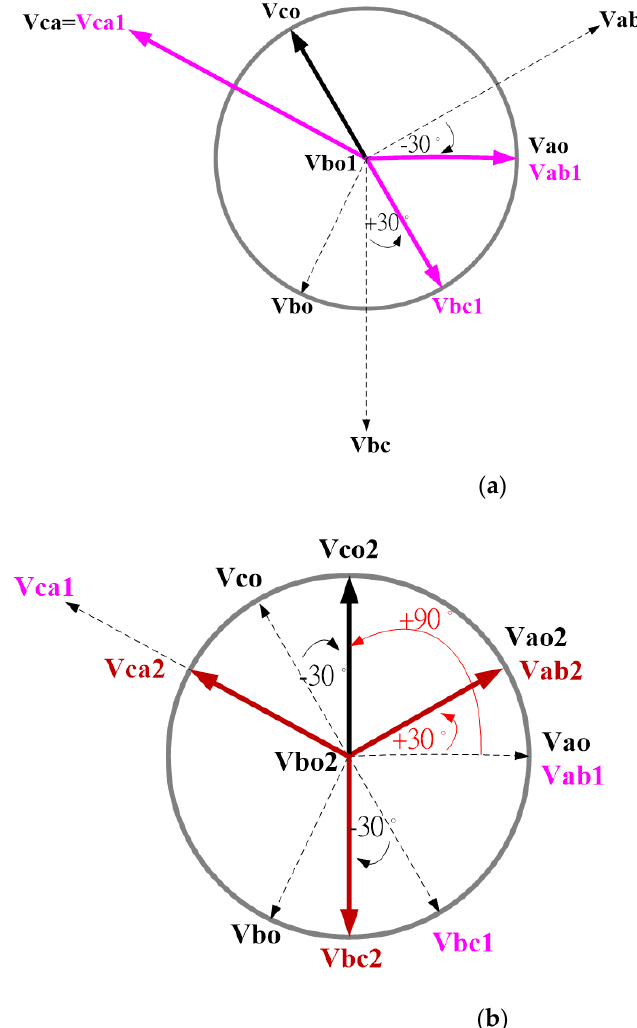
Figure 16. Voltage phasor diagram of fault-tolerant control when a fault occurs in the switch S b 1+ or S b 2 − ; ( a ) unadjusted voltage phase angle; ( b ) adjusted phase angle of the a -phase voltage such that it is 30 ◦ ahead of the original phase angle of the a -phase voltage; adjusted phase angle of the c -phase voltage such that it is 90 ◦ ahead of the original phase angle of the a -phase voltage.